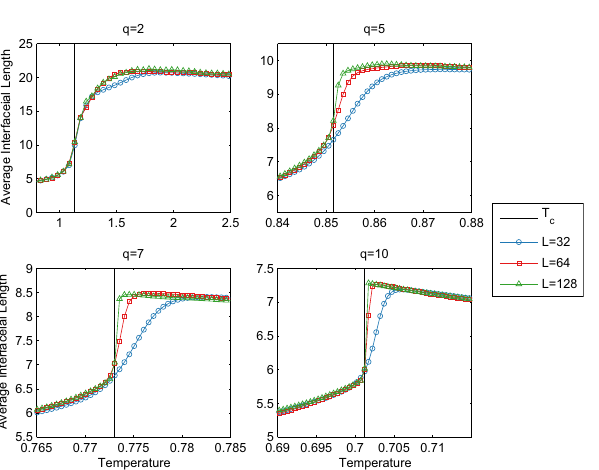
0.5 (Bottom) where each 5 lattice sampled from T T c (0.8515) (Top) and T = = = 3 8 3 6 9 4 )/ 16 7 . Bottom: When one cluster + × + × + × = 4 4 )/ 5 4.4 . + × =